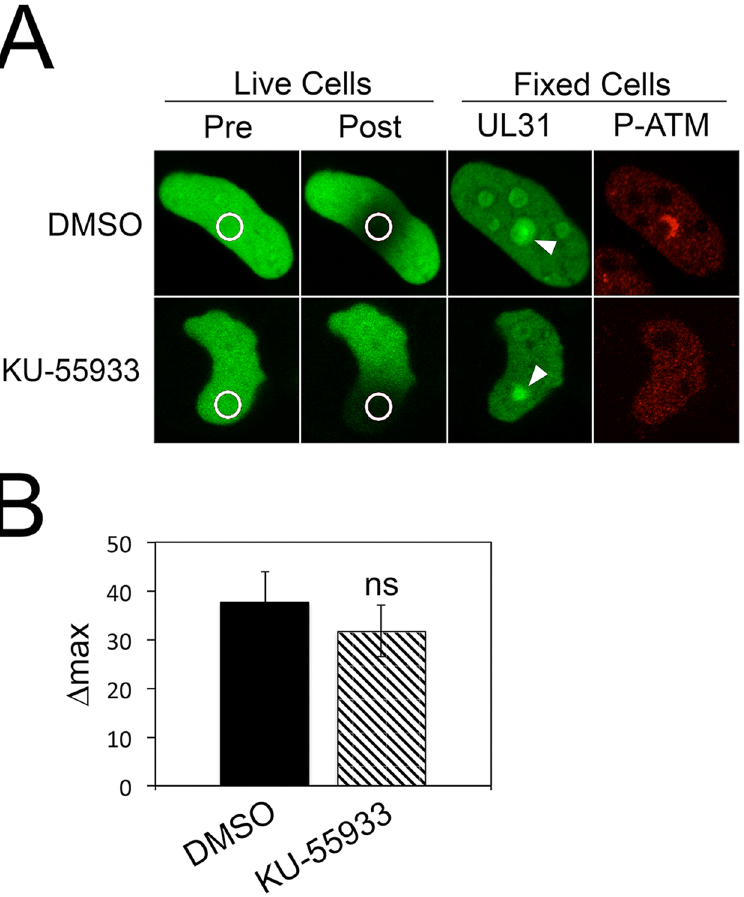
Figure 7. UL31 recruitment to sites of laser microirradiation is not prevented by ATM inhibition ( A ) HeLa cells on grid-bottom dishes expressing EGFP-UL31 were treated with 0.1% DMSO (vehicle) or 10 μ M KU-55933, an ATM inhibitor, two hours prior to imaging. Images of cells were captured immediately before (Pre), and immediately after (Post) the areas indicated by the white circles were microirradiated using an Olympus FV1000 laser-scanning confocal microscope. Cells were immediately fixed and stained with anti- γ H2AX antibody followed by an Alexa 568 conjugated secondary antibody (red signal). Microirradiated cells were relocated and images captured by confocal microscopy. Representative images of 4 cells/condition in two independent experiments are shown. ( B ) Δ max of DMSO and KU-55933 treated cells was determined as described above (n = 8 cells/condition). Error bars represent standard error of the mean. Using an unpaired t -test the Δ max of DMSO treated cells was compared to KU-55933 treated cells and found not to be significant